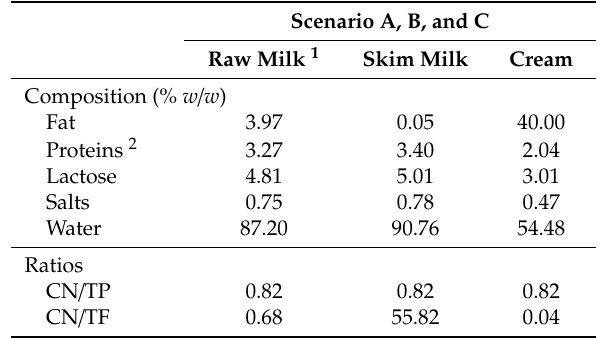
Table 4. Composition of the retentates, permeates, and standardized milks at the standardization step for scenarios A, B, and C.